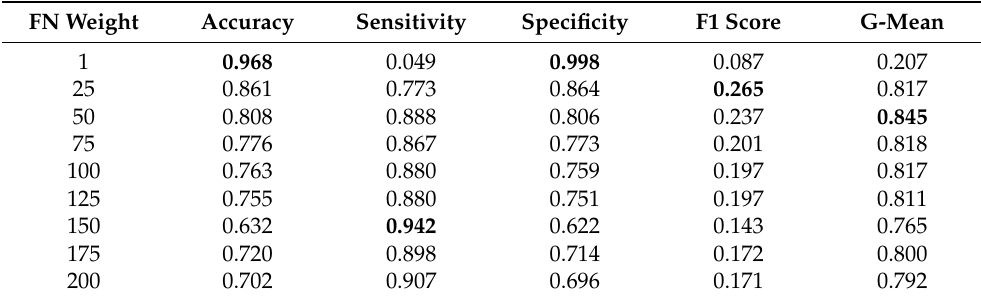
Table 5. The effects of the weight of false negative predictions on all metrics using the CSO (for the dataset of Taiwanese companies). The best result for each metric is marked in boldface.